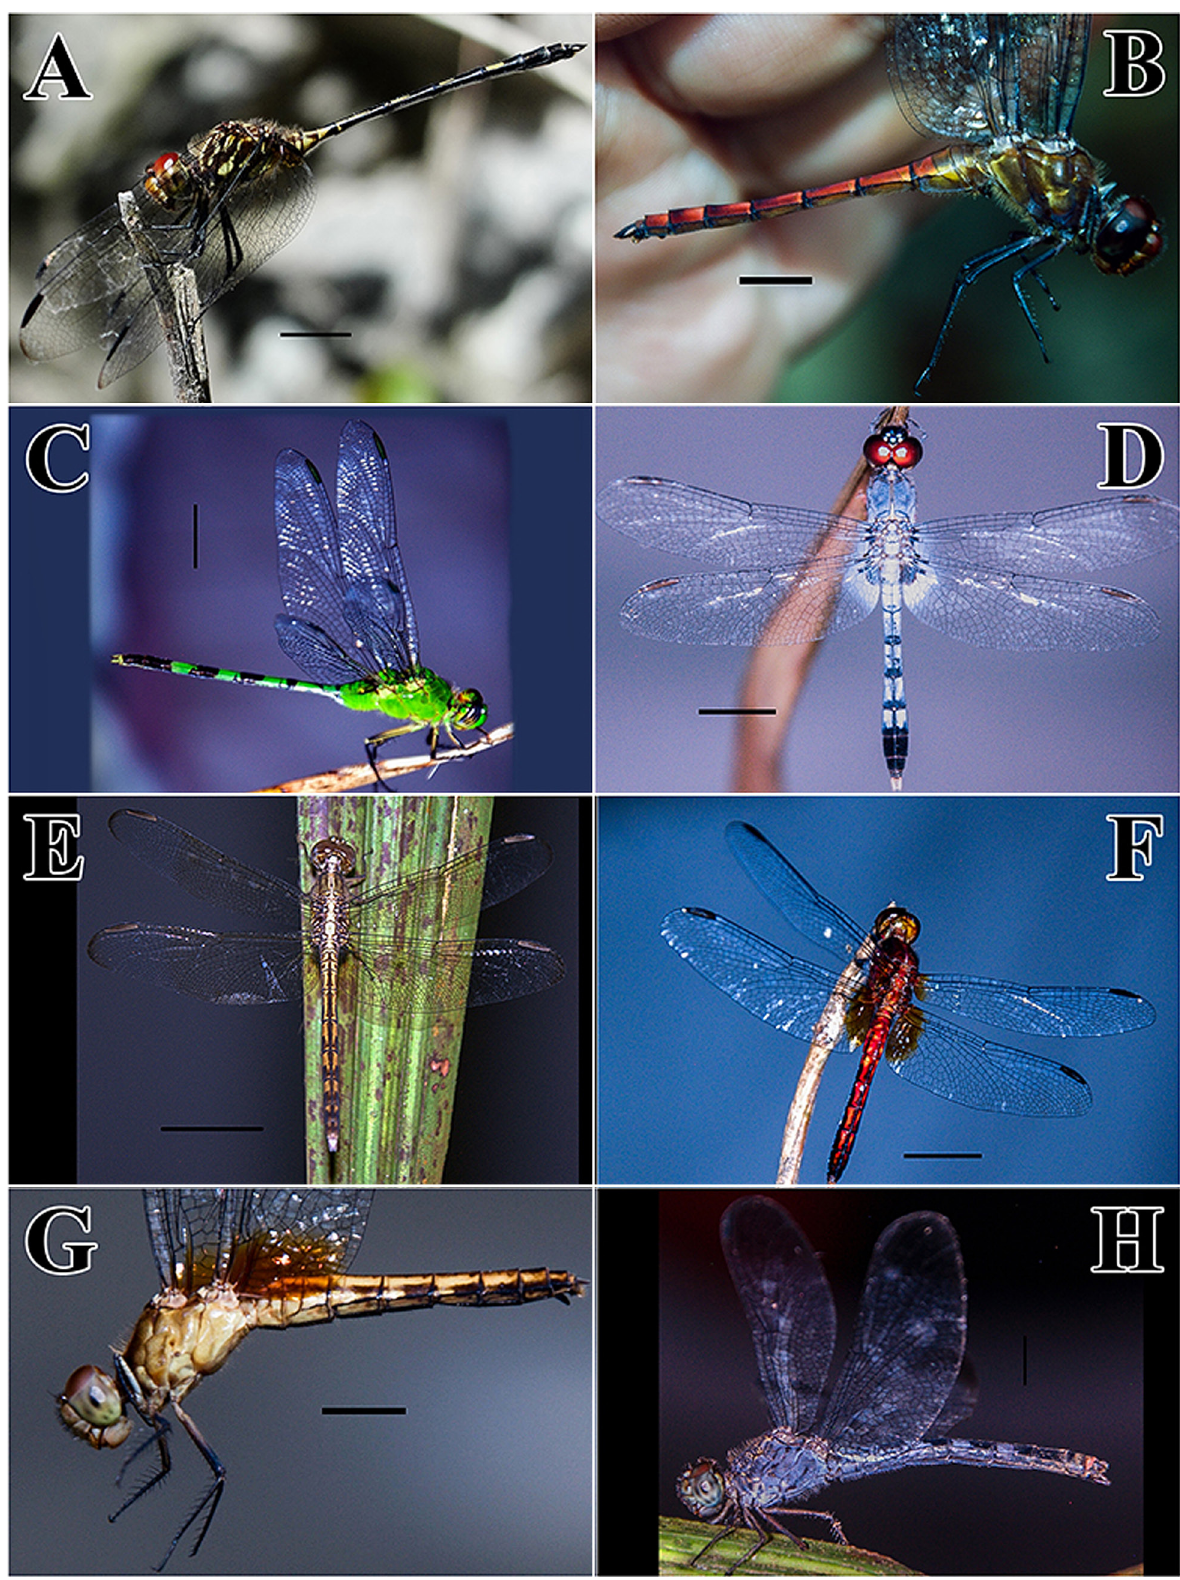
Figure 4. Anisoptera species from Bahia Solano. A. Dythemis sterilis . B. Elasmothemis cannacrioides . C. Erythemis vesiculosa . D. Erythro- diplax andagoya . E. Erythrodiplax funerea . F. Erythrodiplax fusca male. G. Erythrodiplax fusca female. H. Uracis fastigiata . Scale bars = 1